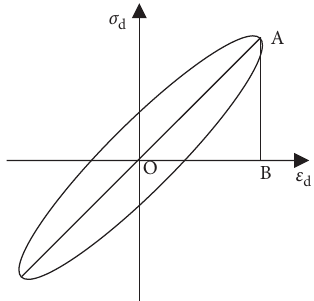
Figure 7: Dynamic stress-strain hysteresis loop. Table 8: Fitting parameters of λ and ε d of W - D cycle path a .